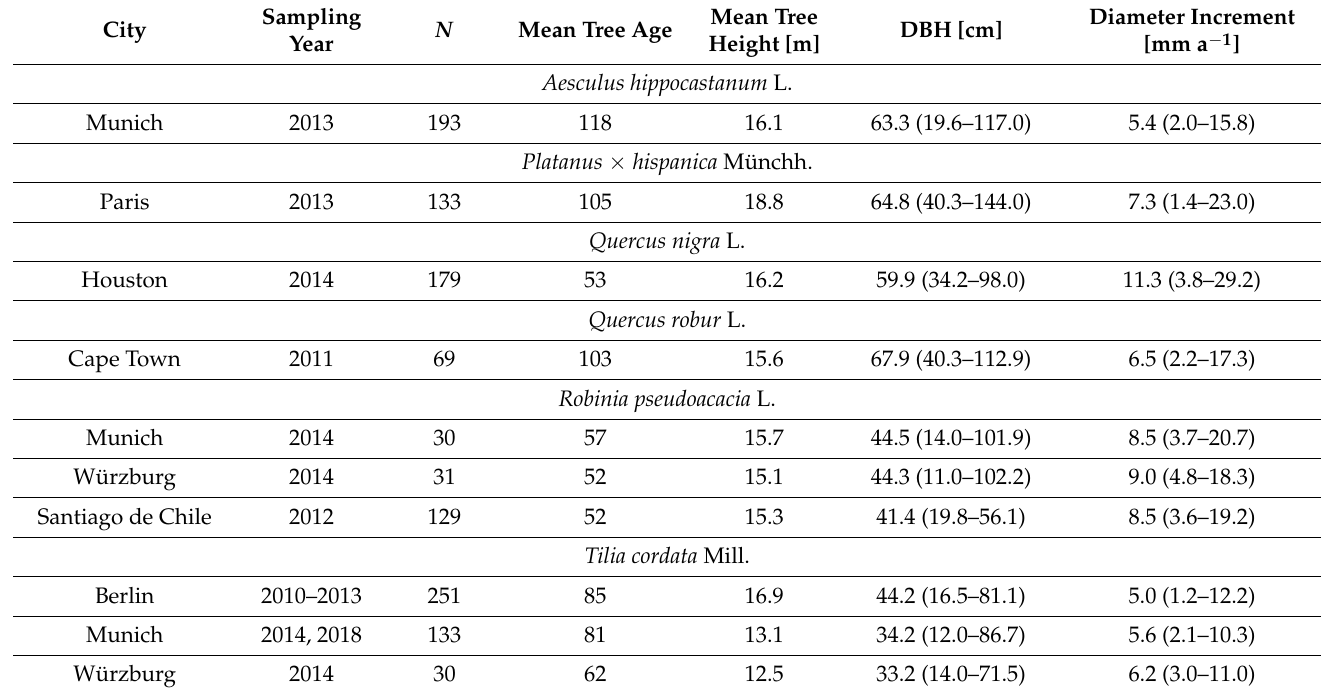
Table 3. Statistical characteristics of the tree ring series from the sampled trees. N = Number